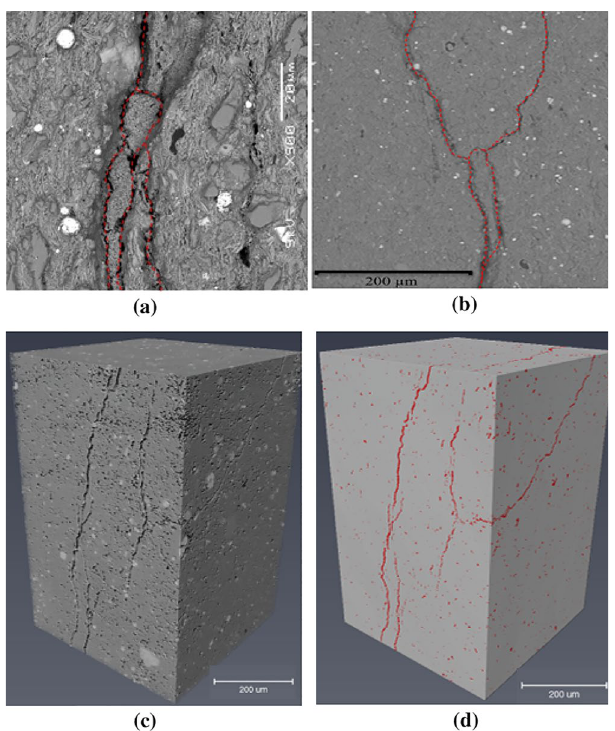
Figure 4. Observations of the shale core used for experiments. ( a ) SEM image of a rock chip. ( b ) SEM image of a microfracture located on the top edge of the core, ( c ) 3D perspective micro-CT X-ray image of the core cut from top. ( d ) Segmented volume micro-CT image; the void porosity and micro-fractures as highlighted in